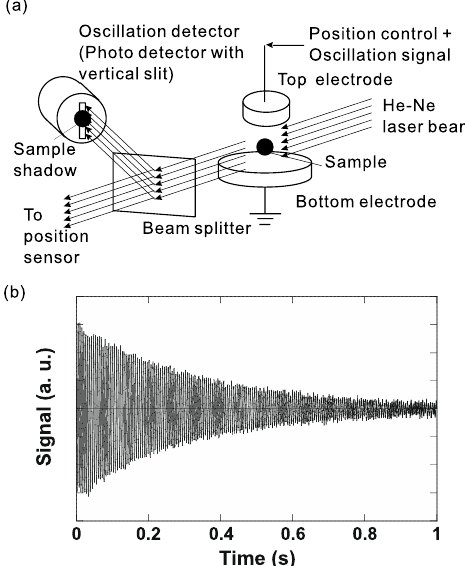
Figure 13. Sample oscillation detection for surface tension and viscosity measurements: ( a ) diameter sensing system and ( b ) decay of the signal of the oscillation following electrical excitation for a molten sample measured by the sensing system.